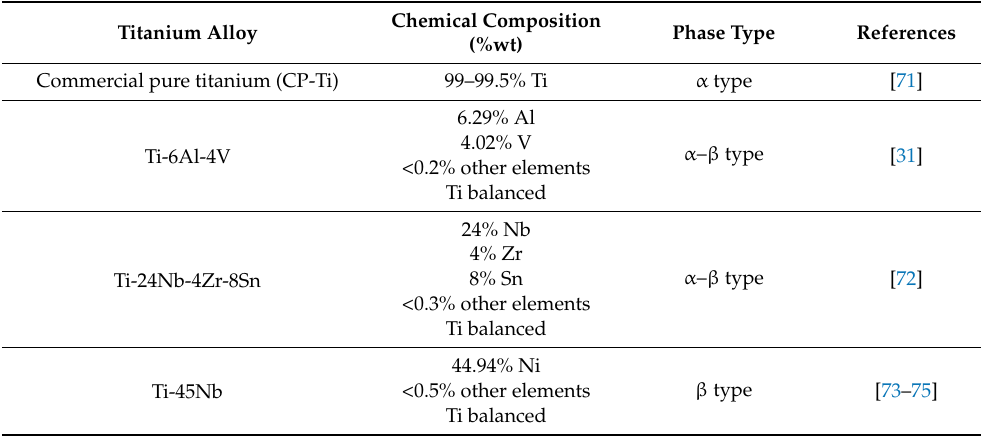
Table 2. Composition of titanium alloys used in lumbar interbody